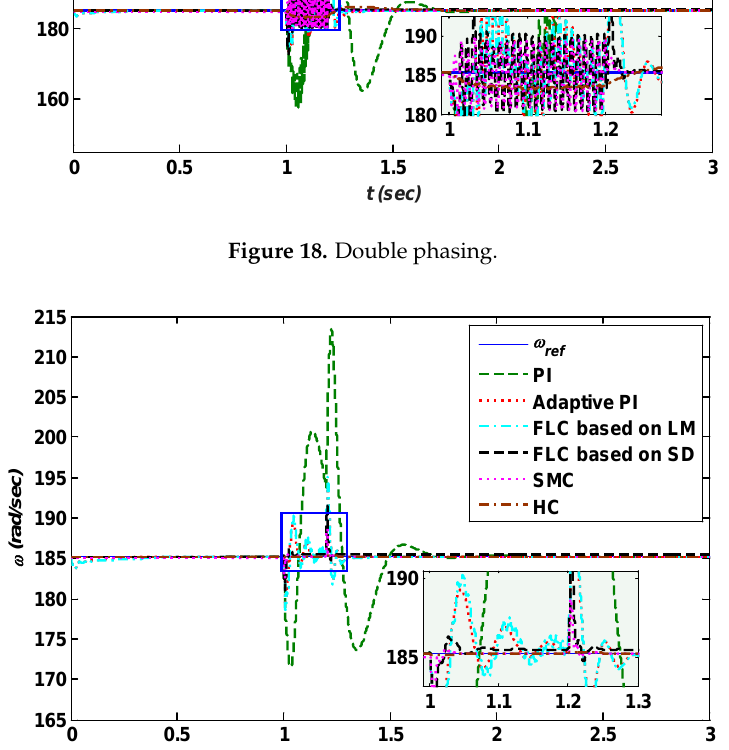
Figure 19. Undervoltage.